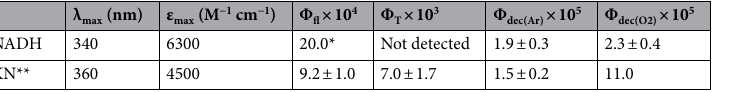
Table 3. Photochemical parameters of NADH and KN: λ max is the wavelength corresponding to the maximum optical absorption in the UV-A range, ε max is the molar absorption coefficient at λ max , Φ fl is the quantum yield of fluorescence, Φ dec(Ar) and Φ dec(O2) are the quantum yields of photodecomposition in an environment saturated with argon and oxygen, respectively. *The value obtained by T.G. Scott et al. 30 . **The data for KN obtained by Tsentalovich et al. 11,42,43